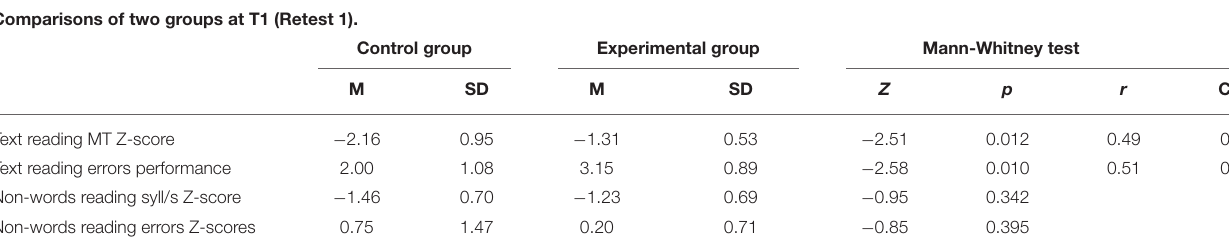
TABLE 4 | Comparisons of two independent groups at T1; values are expressed in raw and Z-scores; errors are codified in agreement with MT guidelines (1: request for immediate intervention; 2: warning request; 3: sufficient performance; 4: criterion completely reached). Comparisons of two groups at T1 (Retest 1).